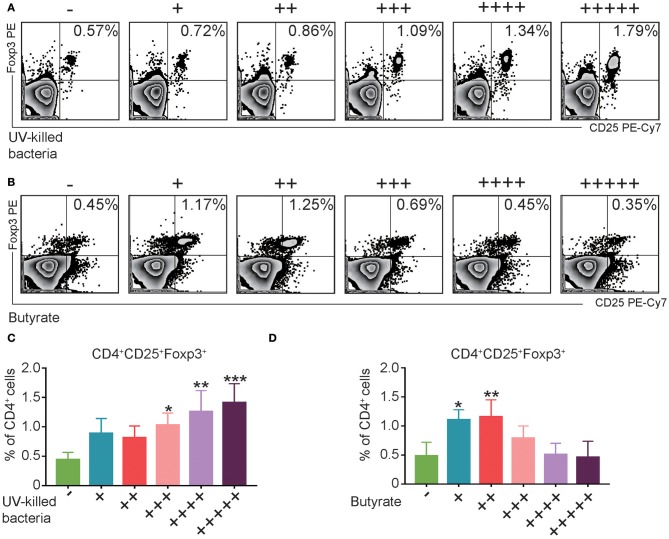
UV-Killed bacteria and butyrate induce regulatory T (Treg) cells in vitro. (A,C) Splenocytes from control Balb/c mice were purified, and then co-cultured with UV-killed bacteria obtained from mice's feces for 12 h, and then the percentages of Treg cells were analyzed by FACS. (B,D) Splenocytes from control Balb/c mice were purified and then co-cultured with butyrate in different concentration (+31.25, ++62.5, + + +125, ++ + +250, and + + + + +500 μM) for 12 h, and then the percentages of Treg cells were analyzed by FACS. Data are representative of three independent experiments with similar results. *P < 0.05, **P < 0.01, ***P < 0.001 (ANOVA/LSD).